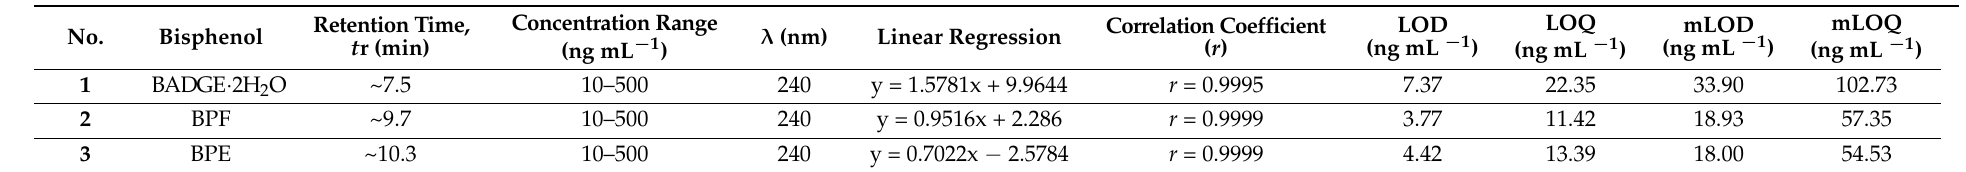
Table 3. Validation parameters for the method: retention times, calibration curves equations (which were constructed using methanol), correlation coefficients ( r ), limits of detection (LODs), and limits of quantification (LOQs) obtained for the three bisphenols by HPLC-FLD. Validation parameters for the method: method limits of detection (mLODs) and method limits of quantification (mLOQs) obtained for the three bisphenols by HPLC-FLD method after SPE of the human urine samples.